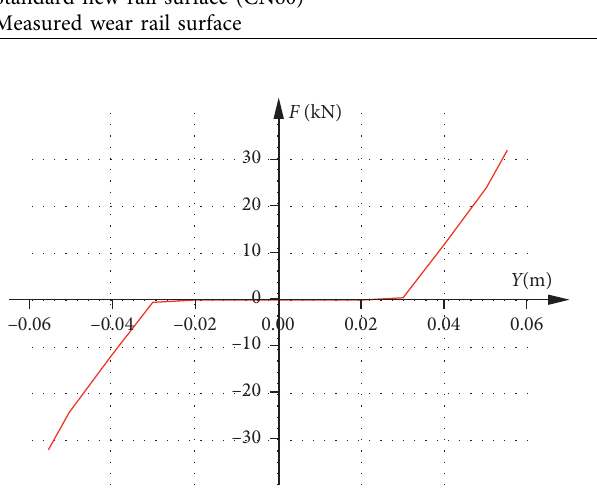
Figure 10: Nonlinear characteristics of lateral bump stop.